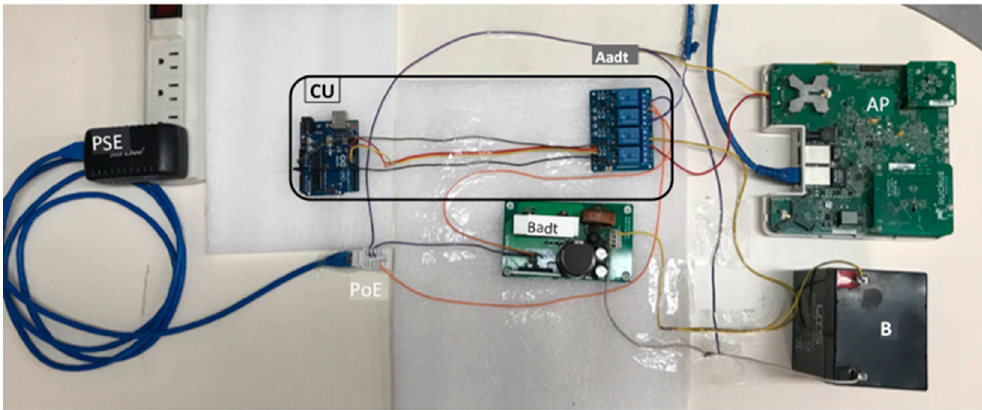
Figure 5. Components of the system that implemented our hardware mechanism.